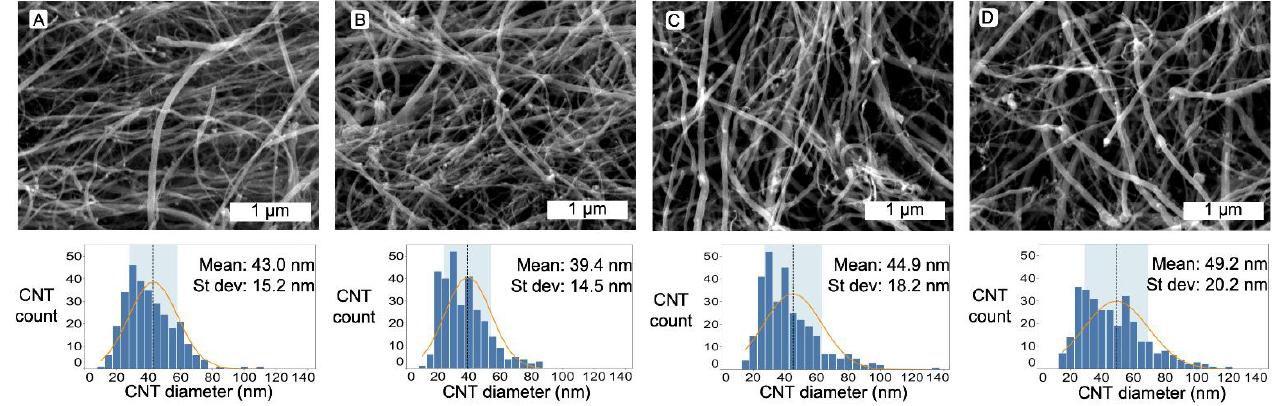
Figure 2. Representative scanning electron microscope images of carbon nanotubes made from ( A ) control with zero PS, ( B ) PS 1 wt%, ( C ) PS 2 wt% and ( D ) PS 4 wt%. Along with histogram data for each sample showing mean and standard deviation for each sample.